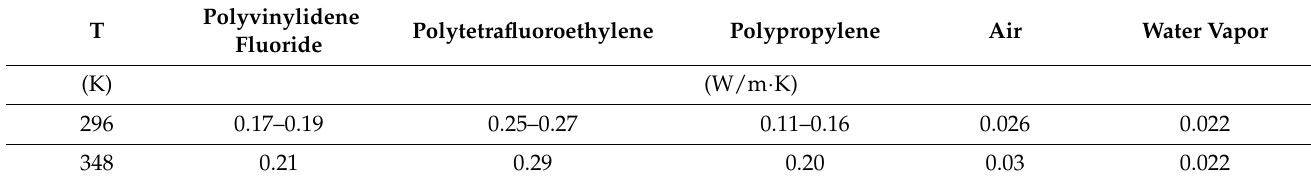
Table 1. Thermal conductivity of some materials or gas involved in